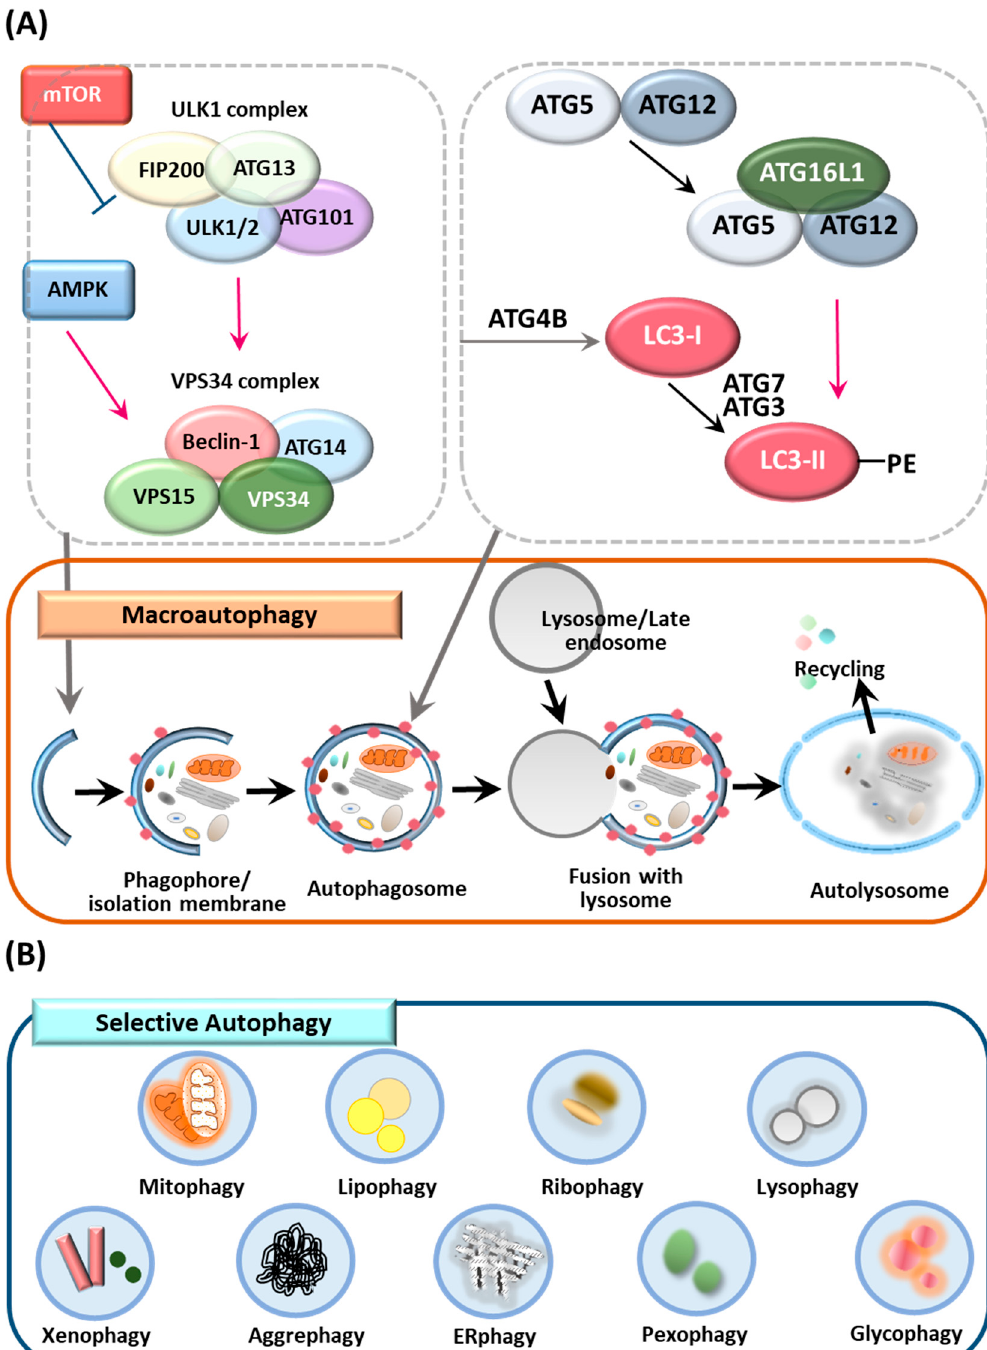
Figure 1. Overview of autophagy, selective autophagy and ATGs ( A ) Molecular machinery of autophagy process. After mTOR inhibition or AMPK activation, the autophagy process begins with the biogenesis of the phagophore/isolation membrane. The ATG16L1-ATG5-ATG12 and LC3-II-PE conjugates participate in autophagosome formation process. The mature autophagosomes are fused with a late endosome and lysosome to initiate degradation of cargos. Finally, cells recycle the released products in cytosol. ( B ) Selective autophagy clears various targets such as subcellular structure, bacteria, protein and lipid aggregates.